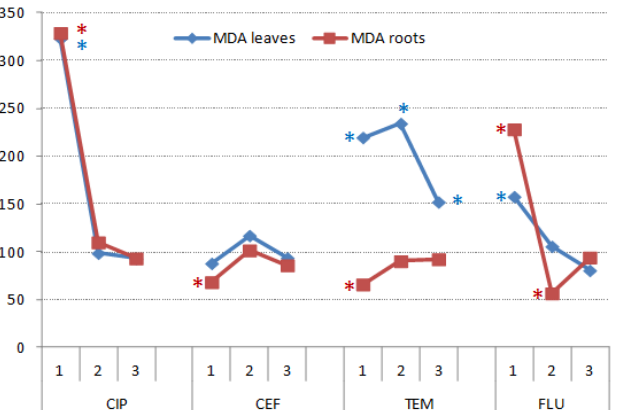
Figure 15. Concentration of MDA in the leaves and roots of wheat germinated under CIP, CEF, TEM and FLU treatments and subsequently grown on complete nutrient solution, recorded in 11-day-old plants. The results are expressed relative to respective controls (control = 100%). Asterisks mark values that were significantly different from respective controls.